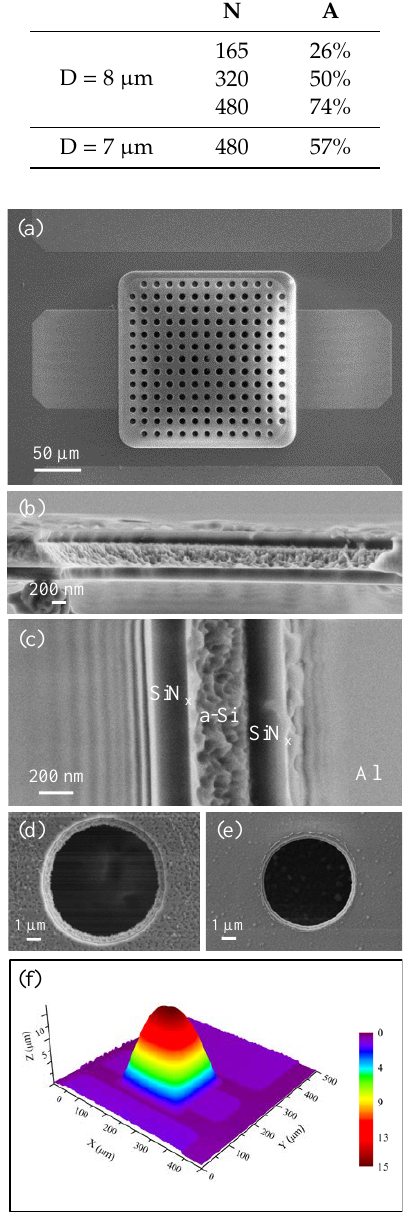
Figure 2. Scanning electron microscopy (SEM) view of a fabricated encapsulating cap ( a ). SEM cross-section of the SiN x /a-Si/SiN x trilayer at lower ( b ) and higher magnification ( c ), along a cleaved hole. SEM view of a hole through the cap surface after barrel etching ( d ) and inductively coupled plasma (ICP) etching ( e ). 3D surface profile of the cap in ( a ) under the application of a stylus tip force of 4.9 µN ( f ).